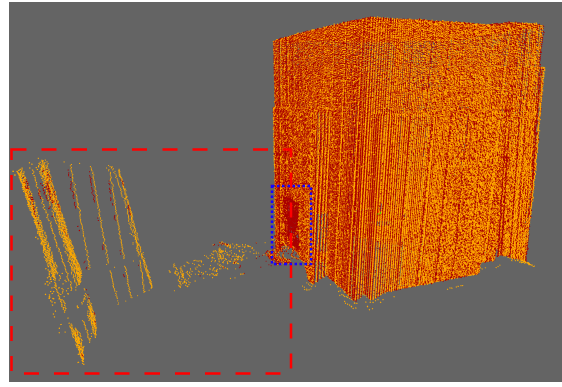
Figure 4: Scan of an empty room. Points of Echo 1 are orange and points of Echo 2 are red. Points behind the mirror are unwanted since they represent a mir- rored object. Since both echoes contain points behind the plane, it is not possible to choose simply one single echo for mapping to prevent the errors. Figure 5 shows the resulting scan after the 3D-Reflection-Pre- Filter was applied. The valid scan points (green) and points on the mirror (turquoise) represent real objects. Therefore they are forwarded to a mapping module. The points behind the mirror plane are coloured orange. These points are displaced by the mir- ror effect. Their location should be in front of the mirror. That is why they are erased from the original point cloud. Hence, a mapping module will not map these points anymore. The real mirror dimensions are 60 cm × 40 cm while the detected mirror dimensions are 60 . 5 cm × 41 . 9 cm. This is very close w.r.t. the precision of the Hokuyo ( ± 3 cm between 0 . 1 − 10 m (Hokuyo, 2016)).